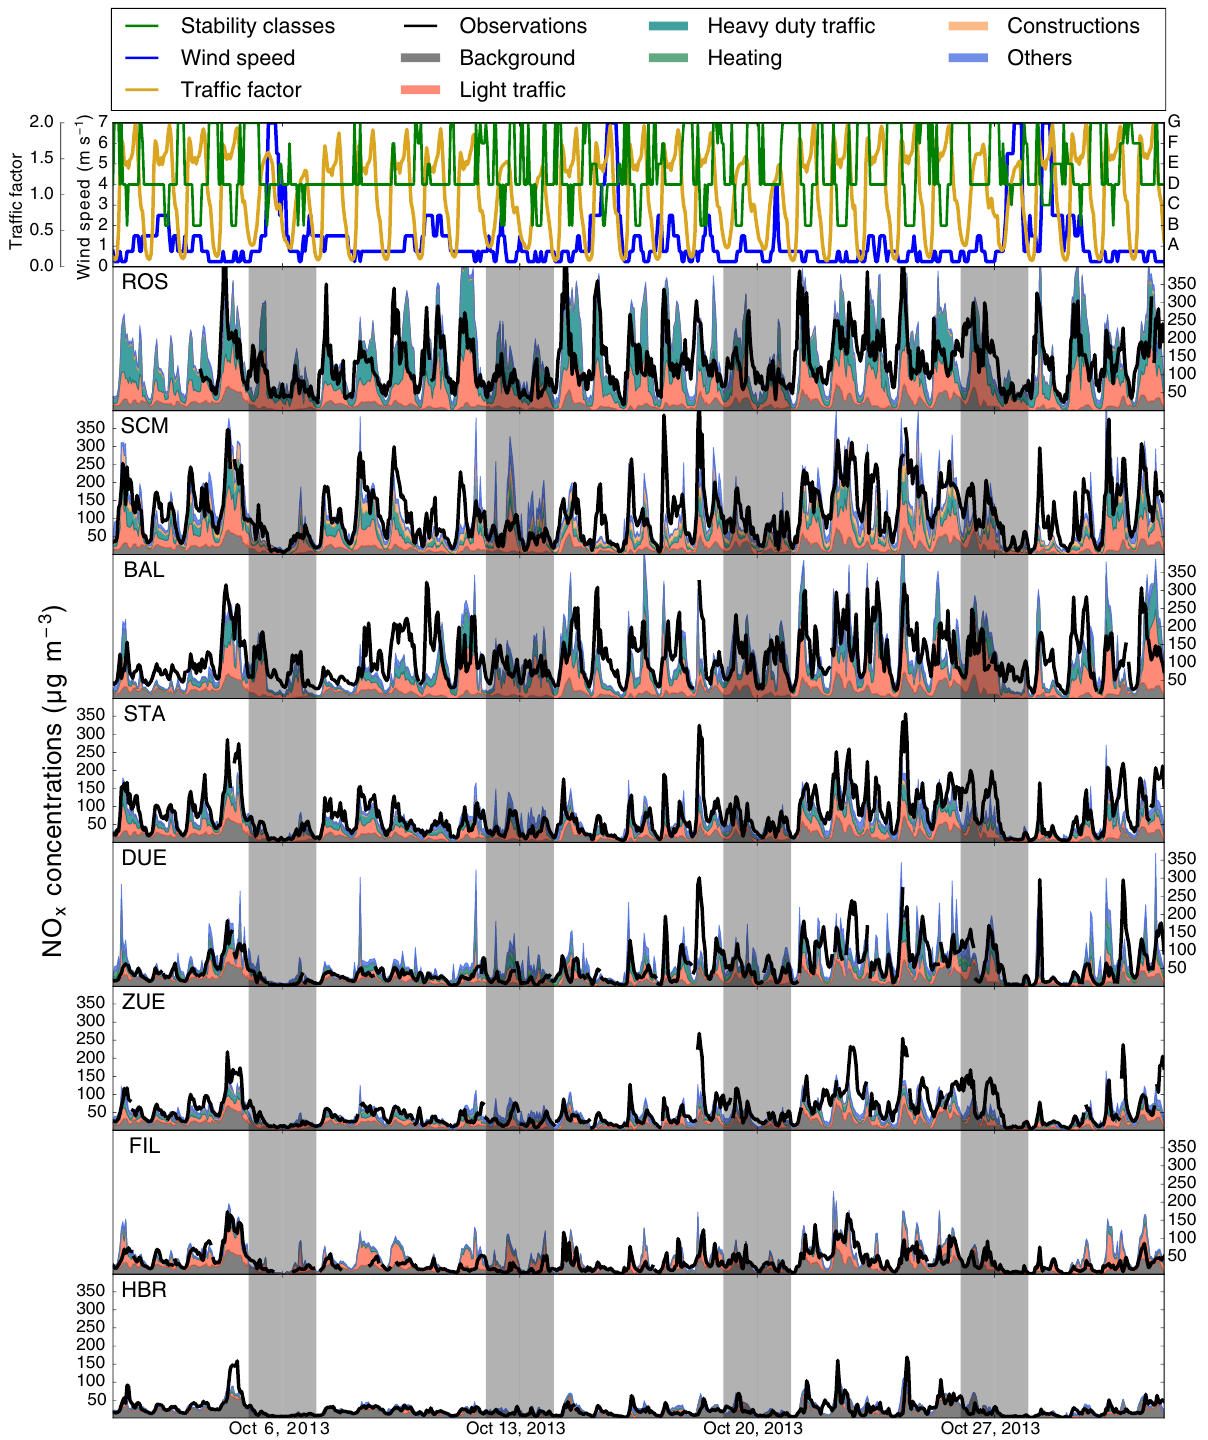
Figure 4. Hourly time series of observed and simulated concentrations at all sites for the month of October 2013. Simulations are separated by contributions from the main emission categories (light traffic, heavy duty traffic, heating and the rest). Shaded periods represent weekends. Top: stability classes and wind categories of the hourly selected weather